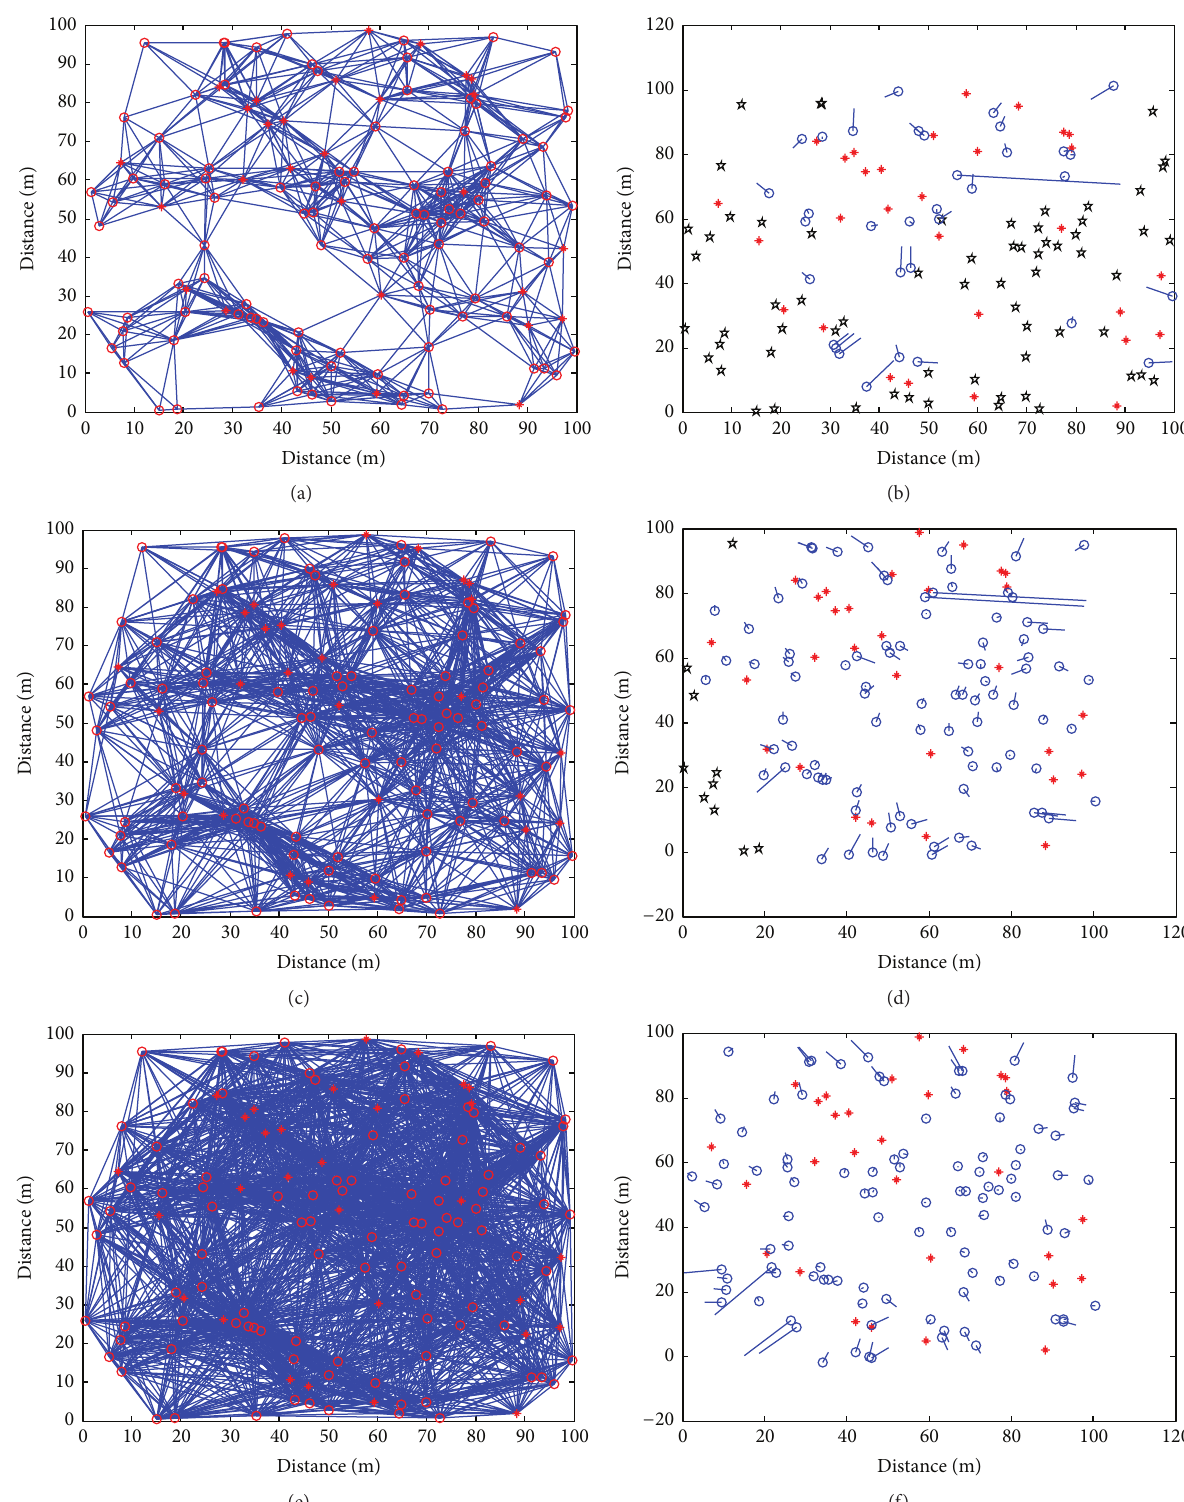
Figure 6: Connectivity and localization effect ((a), (c), and (e) are the neighbor relationship of nodes for the communication radius of 20 m, 30 m, and 40 m, resp. (b), (d), and (f) are the localization error for the communication radius of 20 m, 30m, and 40 m, resp. The number of beacon nodes is always